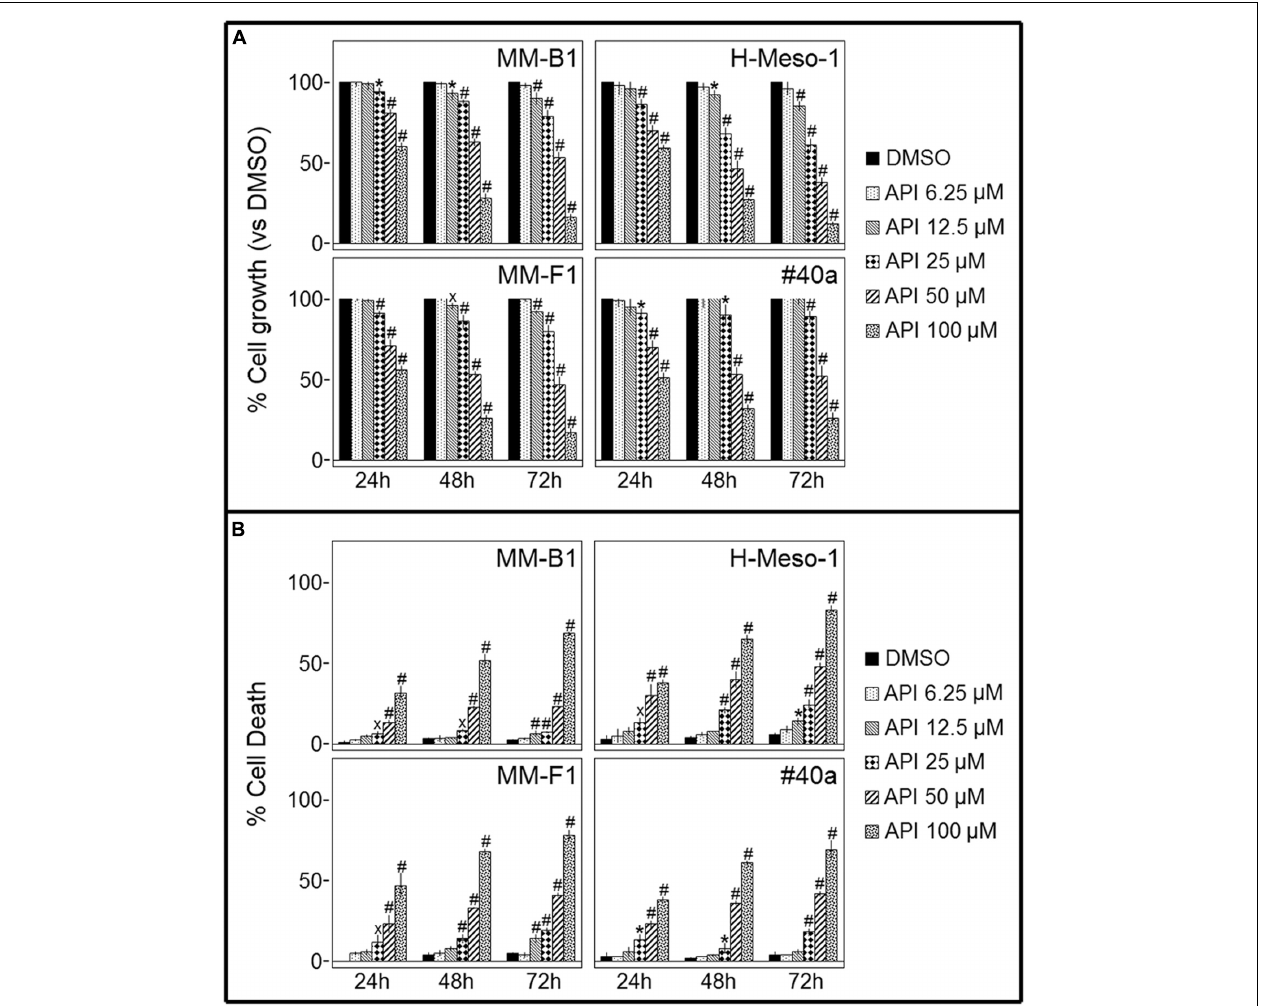
FIGURE 1 | Effect of Apigenin (API) on malignant mesothelioma (MM) cell lines growth and death. (A) The growth of human (MM-B1, H-Meso-1, MM-F1) and mouse (#40a) MM cell lines were assessed by the SRB assay after 24, 48, and 72 h of treatment with DMSO or API. The percentage of cells growth treated with API was calculated by normalizing the O.D. value to that of the control cultures (DMSO). The results are expressed as the mean ± SD of three independent experiments performed in triplicate ( x p ≤ 0.05, ∗ p ≤ 0.01, # p ≤ 0.001 compared with the cultures treated with DMSO). (B) Trypan blue exclusion test was performed to determine the percentage of cell death of MM cells treated with API or DMSO after 24, 48, and 72 h of treatment. The results are expressed as the mean ± SD of three independent experiments performed in triplicate ( x p ≤ 0.05, ∗ p ≤ 0.01, # p ≤ 0.001 compared with the cultures treated with